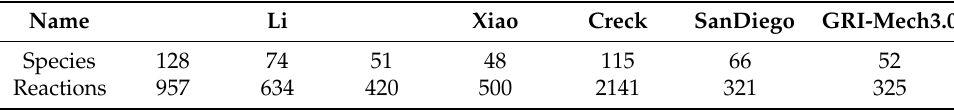
Table 3. Outline of the chemical reaction